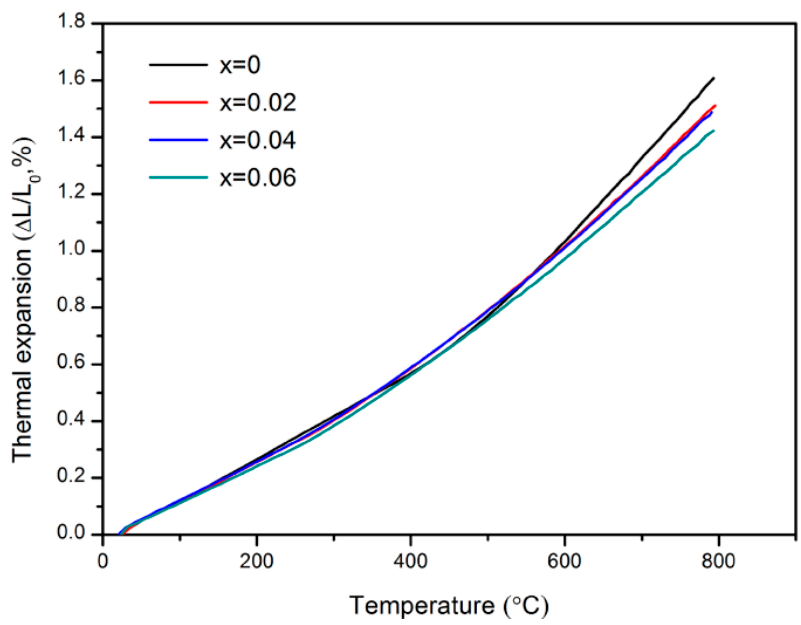
Figure 4. Thermal expansion curves of LBCM x ( x = 0–0.06) from 25 °C to 800 °C. The thermal expansion coefficients (TECs) calculated from the curves are listed in Table 2. Doping Mo reduces the TECs of the samples from 20.87 × 10 − 6 K − 1 to 18.47 × 10 − 6